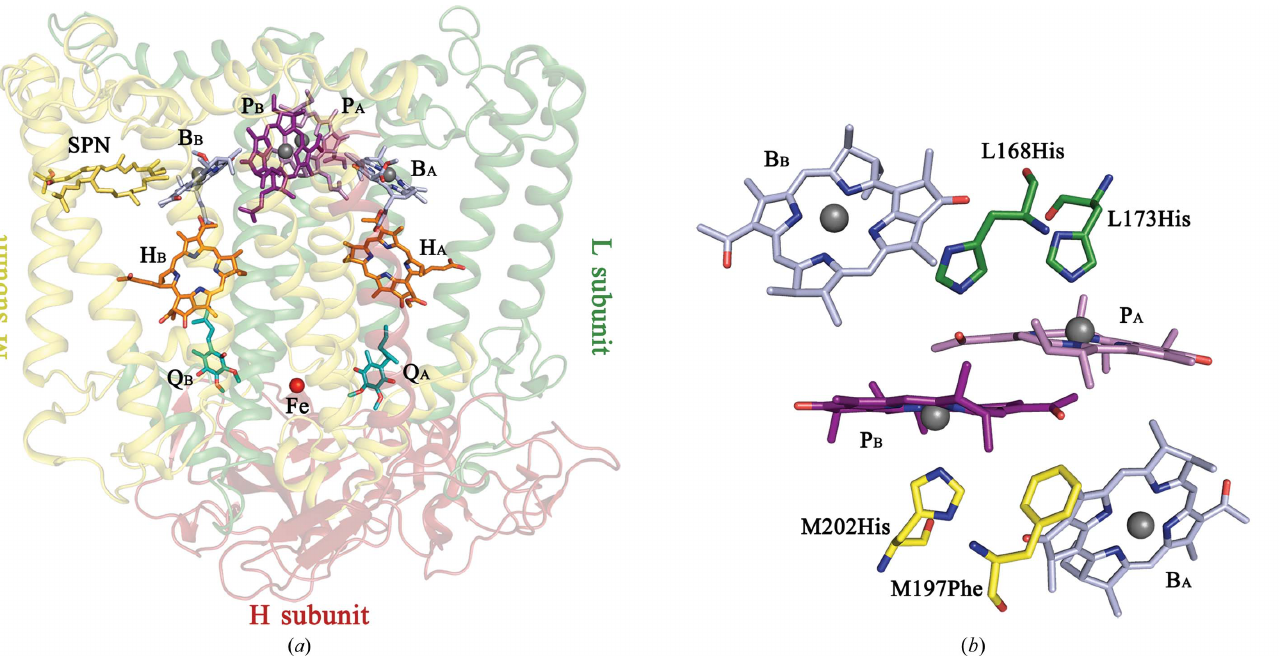
Figure 1 ( a ) Overall structure of R. sphaeroides RC (PDB entry 3v3y). P A and P B , special pair of bacteriochlorophylls; B A and B B , monomeric bacteriochlorophylls; H A and H B , bacteriopheophytins; Q A and Q B , quinones; SPN, carotenoid spheroidene. ( b ) Bacteriochlorophylls in the structure of wild-type R. sphaeroides RC. The view is along the axis of twofold symmetry from the periplasmic side of the membrane. His L168 and Phe M197 near the acetyl carbonyl groups of BChls P A and P B are shown. His L173 and His M202 are ligands of BChls P A and P B ,